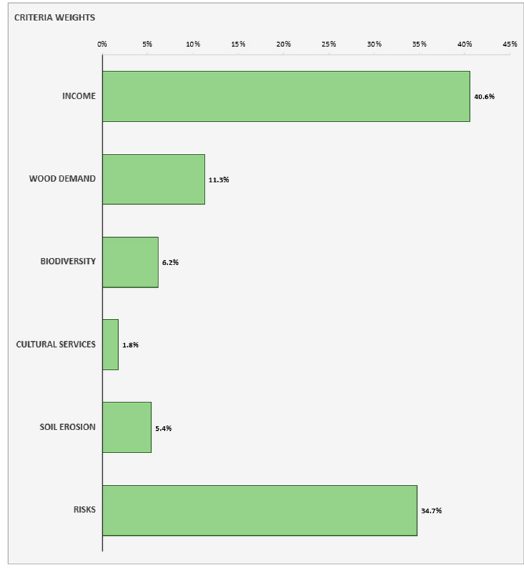
Figure 5. Multicriteria questionnaire: judging the importance of criteria by eliciting weights by pairwise comparisons.